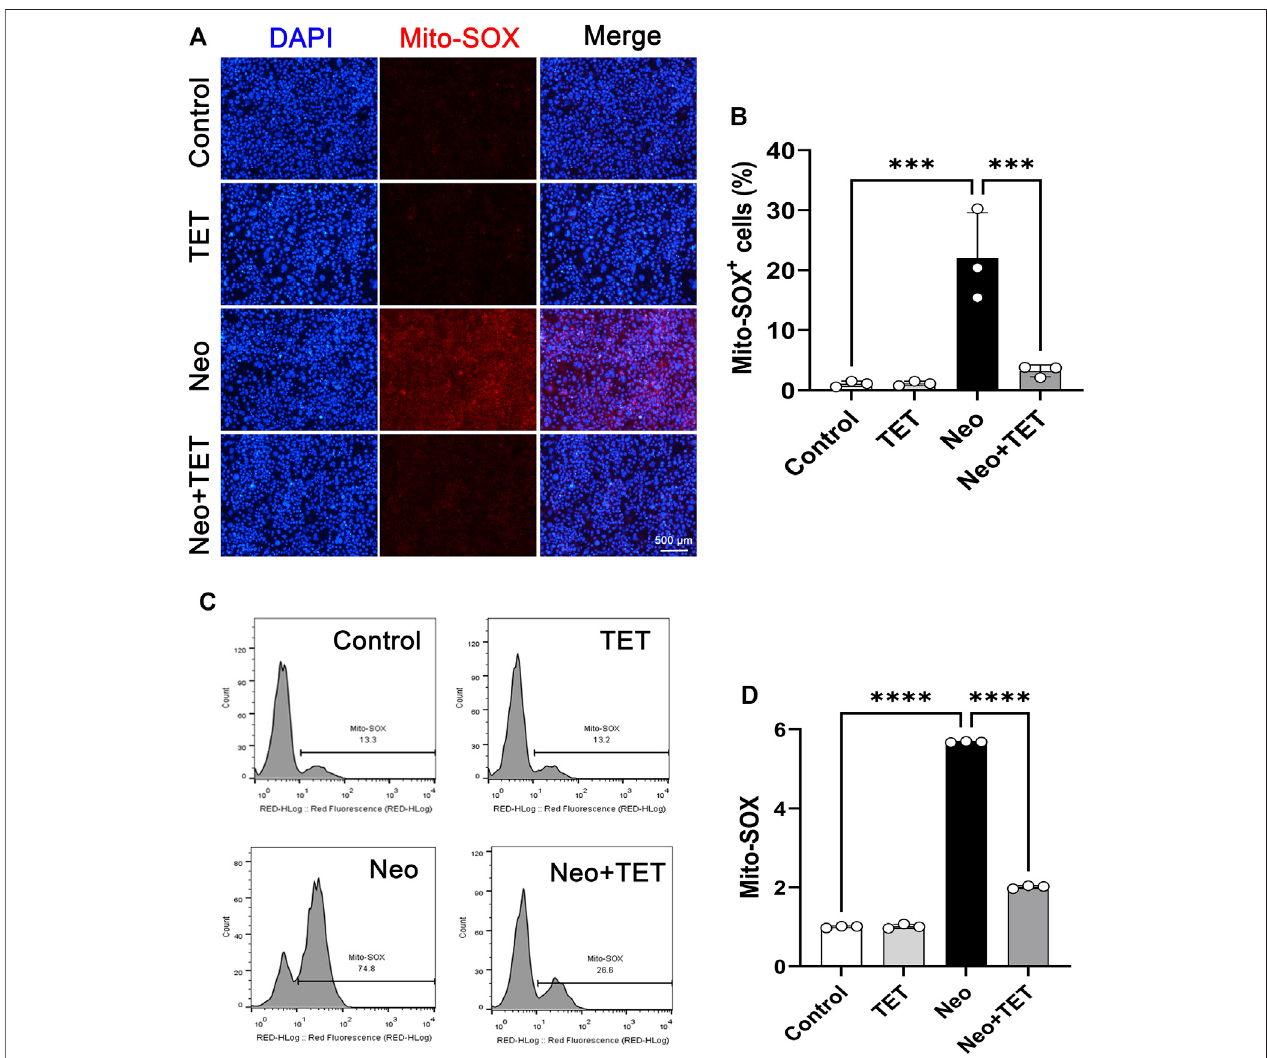
FIGURE 5 | Effects of TET on neomycin-induced oxidative stress in HEI-OC1 cells (A) HEI-OC1 cells were labeled with a Mito-SOX staining kit (n = 3). Scale bars: 500 μ m (B) Quanti fi cation of the numbers of Mito-SOX-positive HEI-OC1 cells in (A) (n = 3) (C) ROS accumulation was further con fi rmed by fl ow cytometry (n = 3) (D) Quanti fi cation of the results of fl ow cytometry in (C) . *** p < 0.001, **** p < 0.0001.